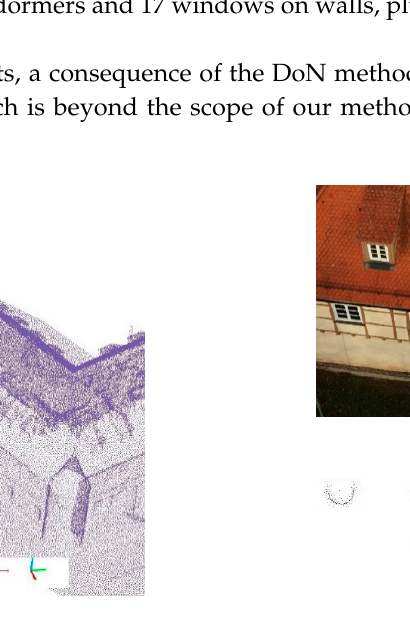
Figure 21. Circular window detection by DoN method.